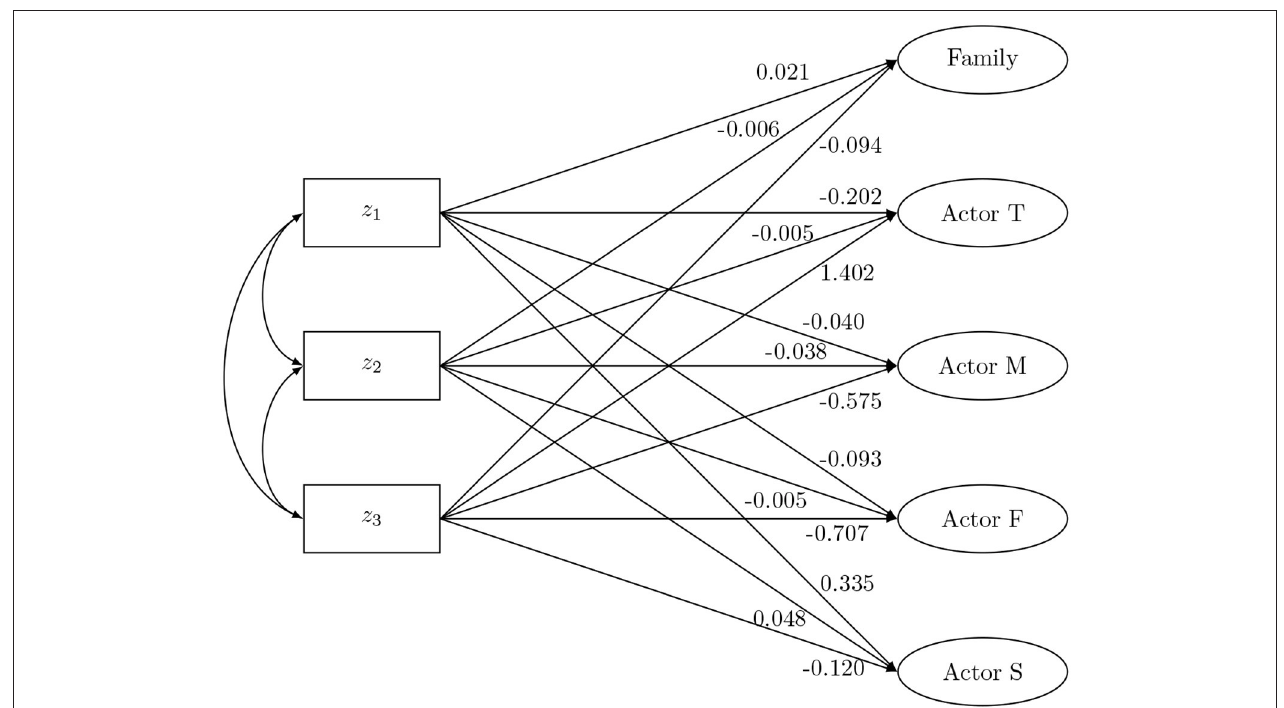
FIGURE 5 | The social relations model components as outcome: data-generating model.